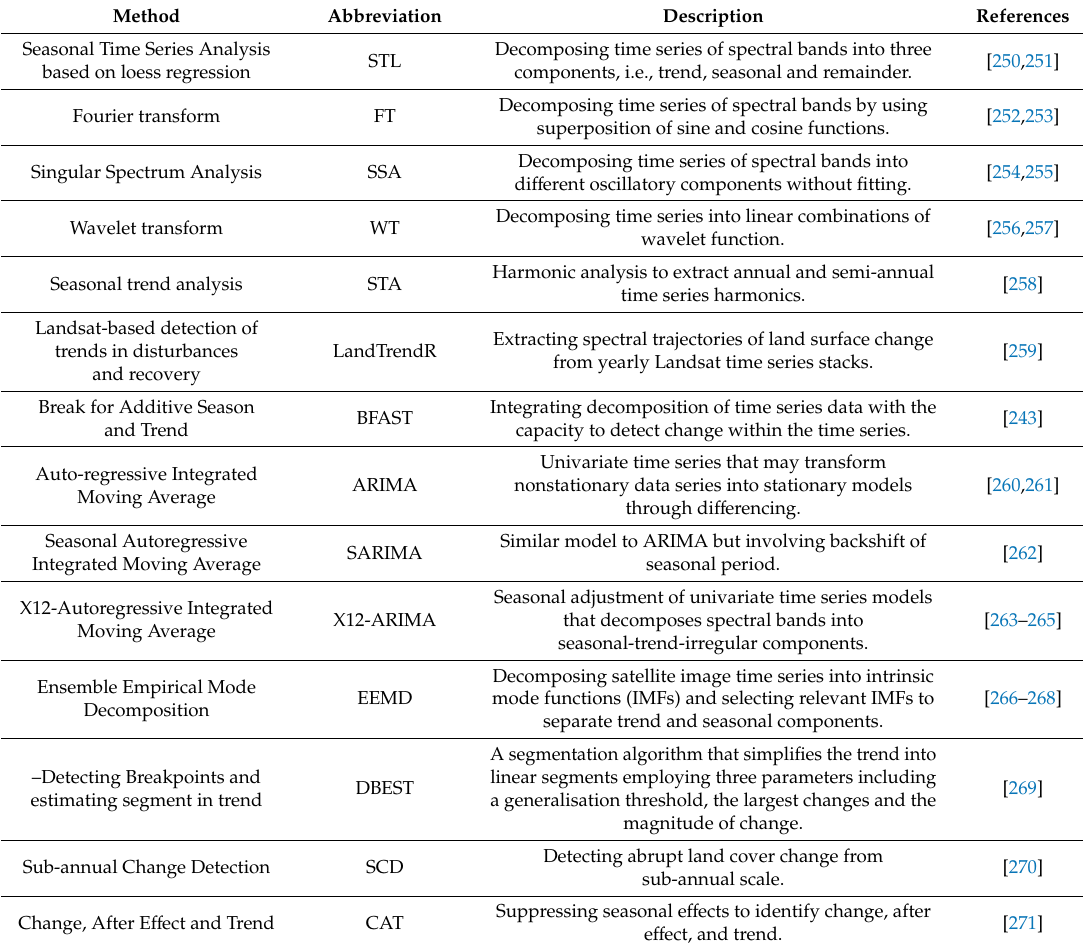
Table 4. Major time series decomposition techniques for LCC-related